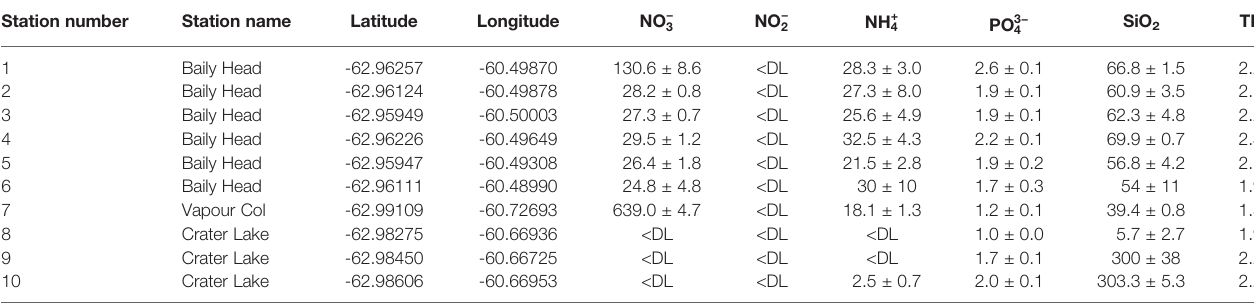
TP, Total Phosphorous; DL, indicates Detection Limit.